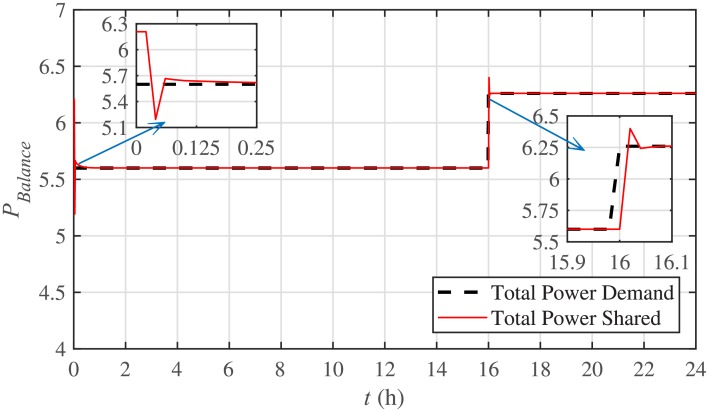
Power balance under case 1.